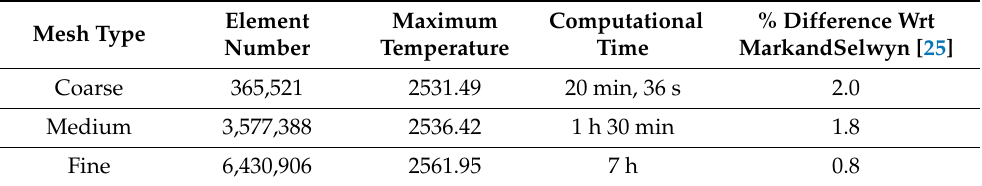
Table 4. Grid independence analysis based on computational time and percentage difference with the reference value.